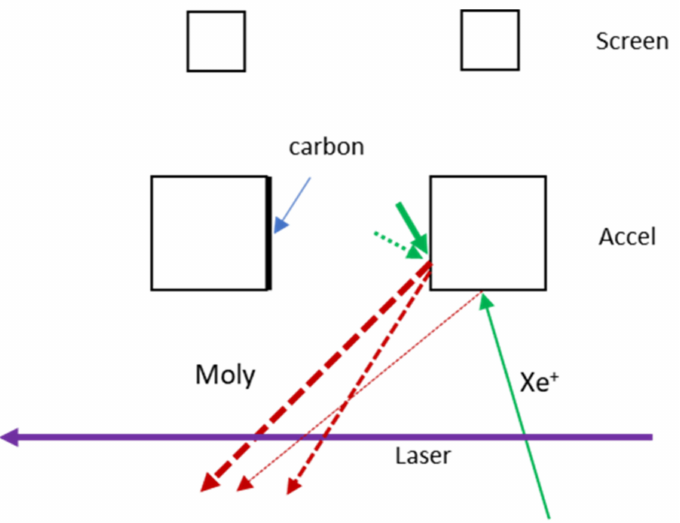
Figure 11. Diagram of a single screen and accel grid aperture pair (not to scale), illustrating hypothet- ical scenarios for Xe + impingement trajectories and associated directionality for peak molybdenum density distributions. The diagram applies to grid locations away from the center. Preferential carbon deposition sites and radial velocity of backstreaming CEX ions are potential causes of moly directional bias. Cusps are an artifact of the grid formation process and gradually wear away; they are not